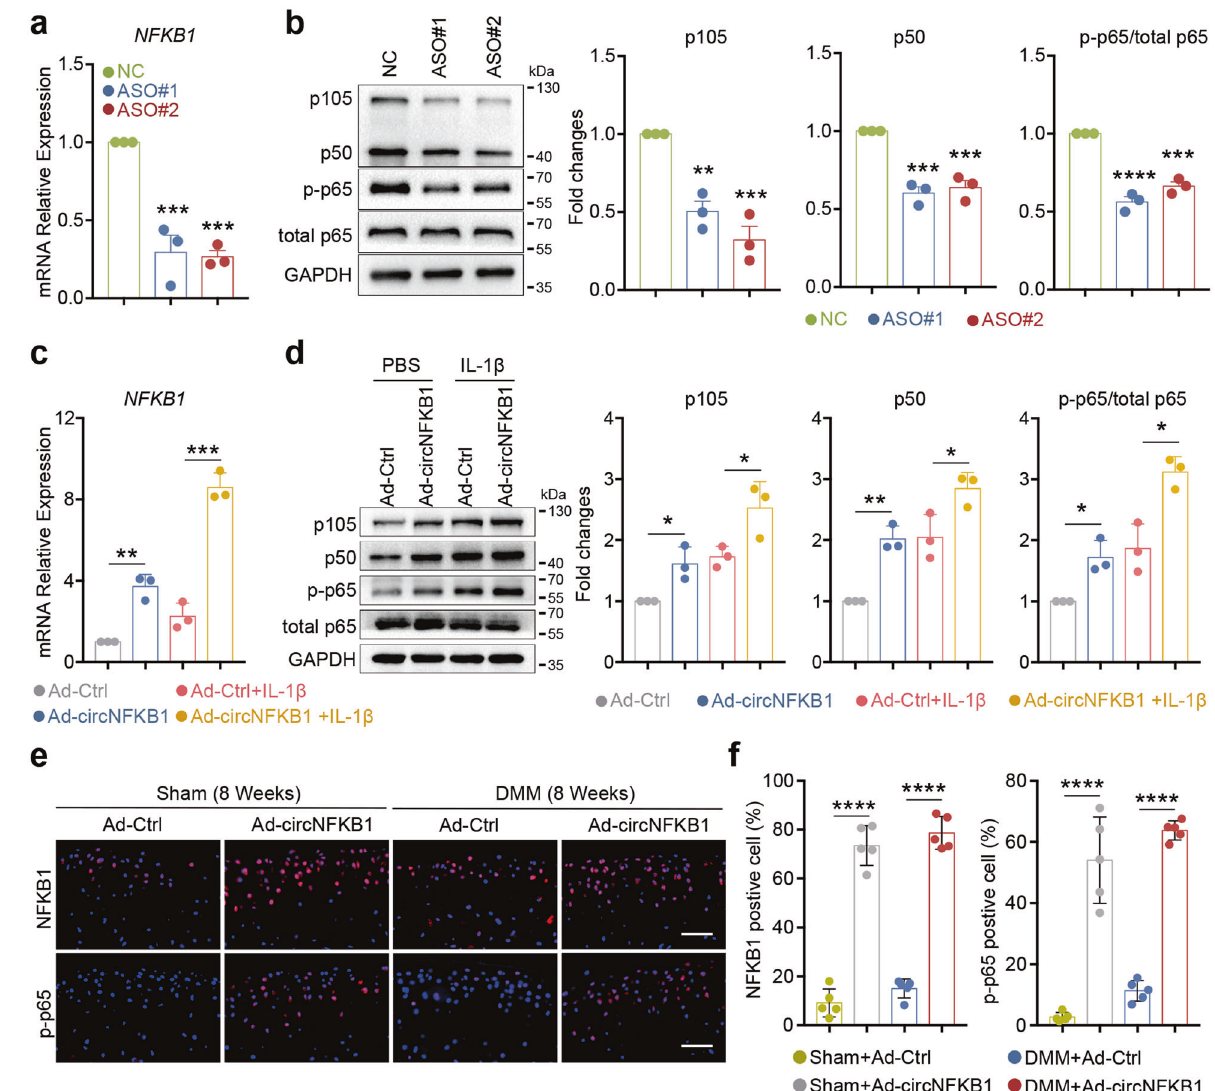
Fig. 7 circNFKB1 regulates NFKB1 expression and sustains NF- κ B signaling pathway. a qRT-PCR analysis showing NFKB1 mRNA levels after circNFKB1 knockdown in HCs. b Western blotting analysis showing p105, p50 and p65 phosphorylation protein levels in